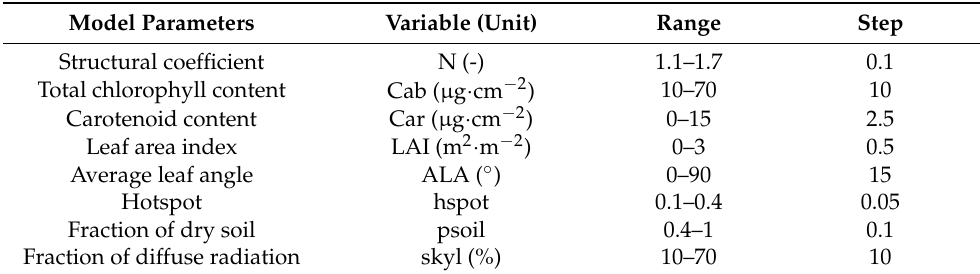
Table 2. PROSAIL parameter range of variation for the LSA.